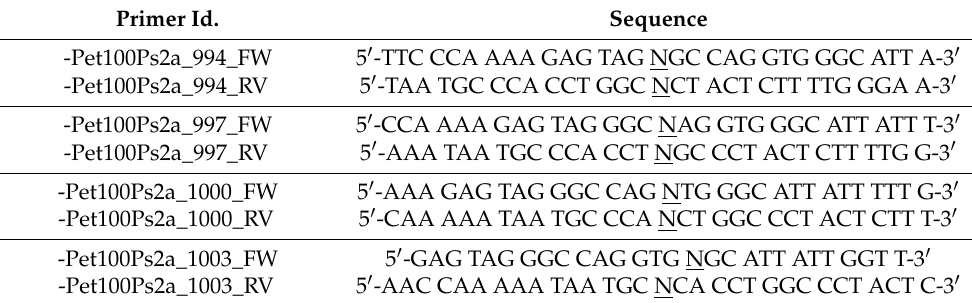
Table 7. Primers designed for site-directed mutagenesis of PS2Aa1. Primer